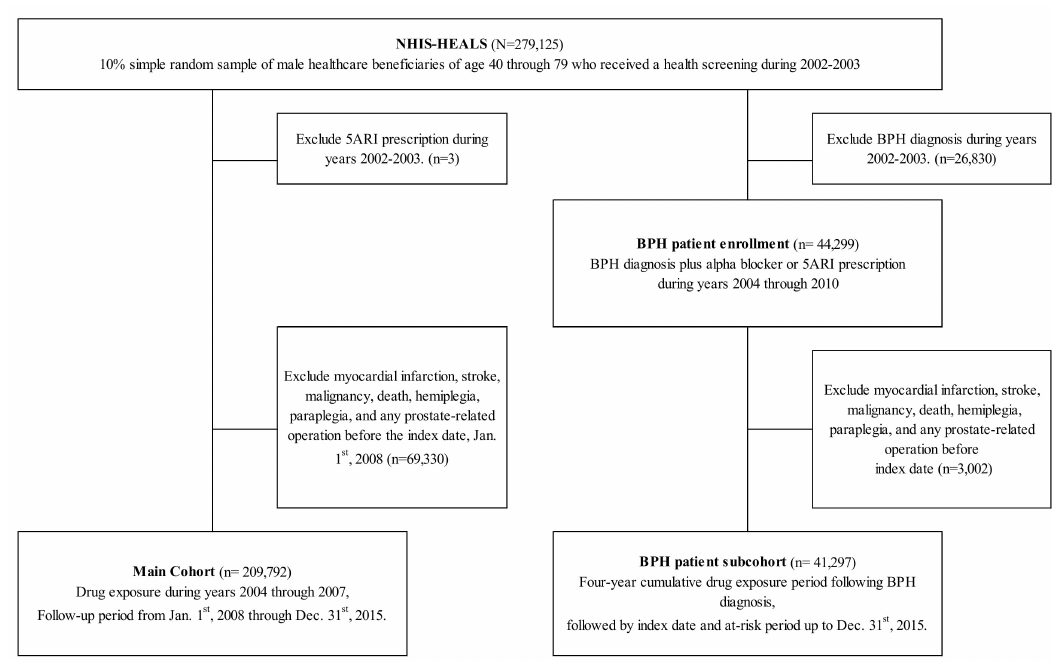
Figure 1. Study Design of the Male Cohort and Benign Prostatic Hyperplasia